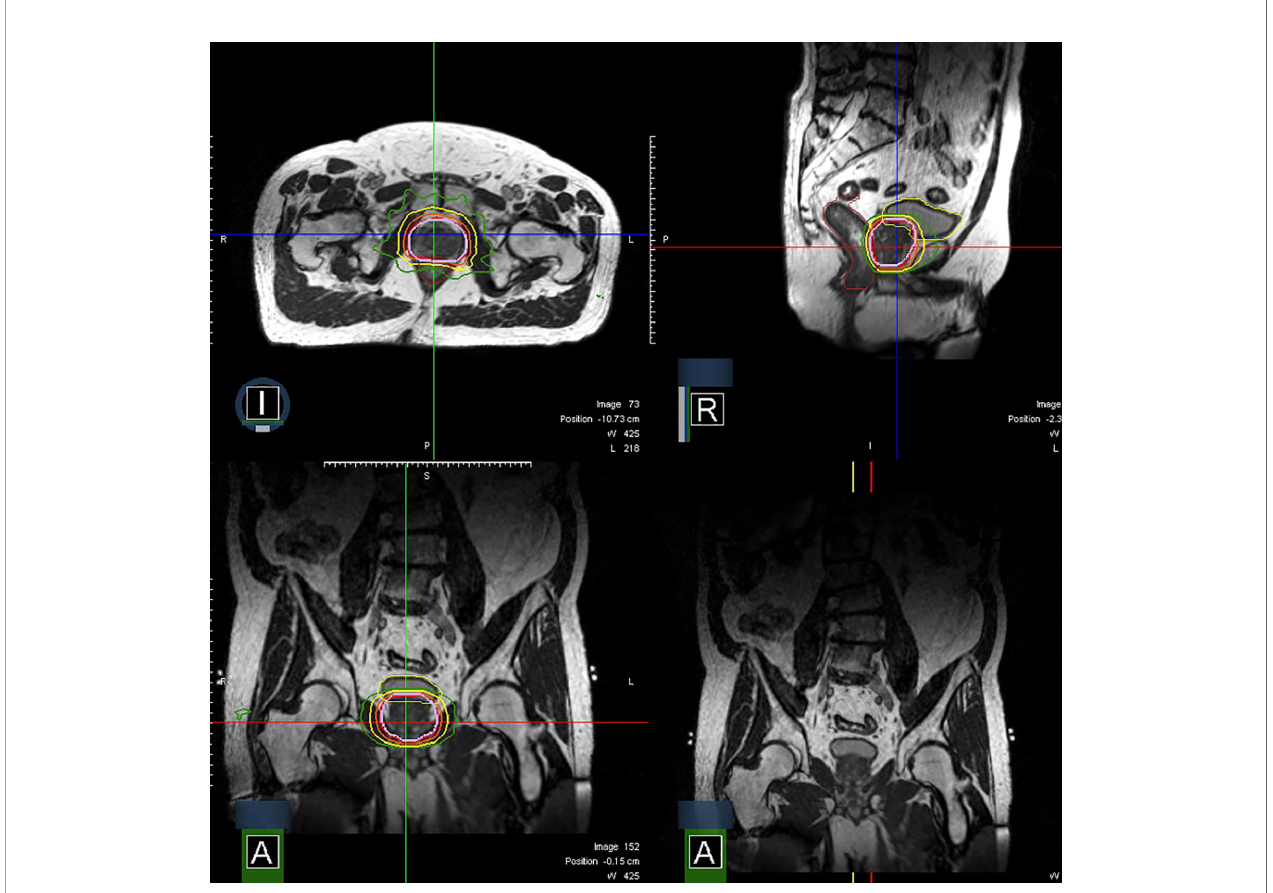
FIGURE 2 | Axial, sagittal, and coronal images of a prostate plan on the MRIdian (isodoses: Red = 40 Gy, Orange = 36 Gy, Yellow = 24 Gy, Green = 20